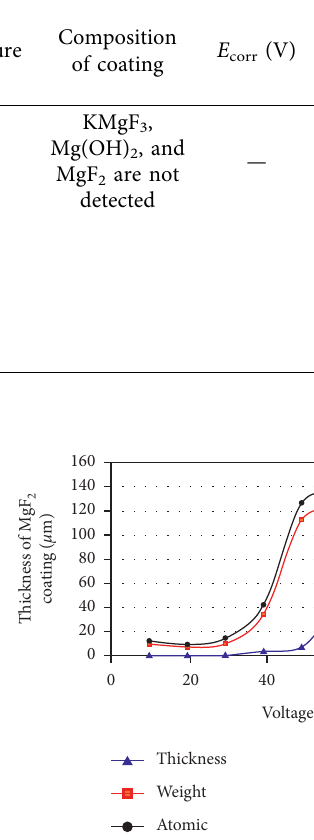
Figure 5: Variation of coating thickness and chemical composi- tions with processing voltage. In the figure, the blue triangle data point curve corresponds to the variation of coating thickness with the voltage